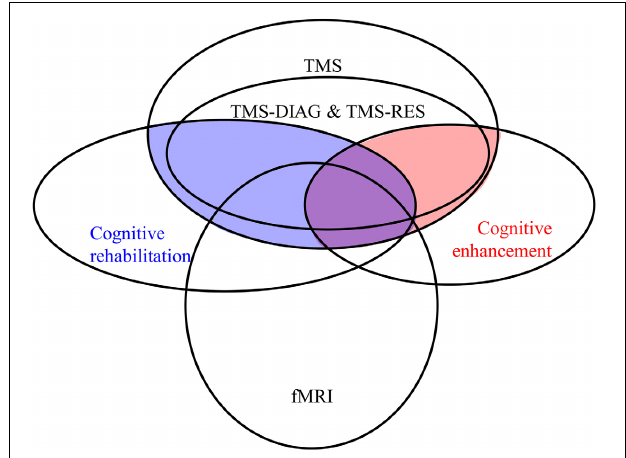
FIGURE 1 | Qualitative approximation of a larger context for CR- and CE-TMS. Topics are represented by ellipses with CR-TMS (filled blue) and CE-TMS (red) representing intersections of